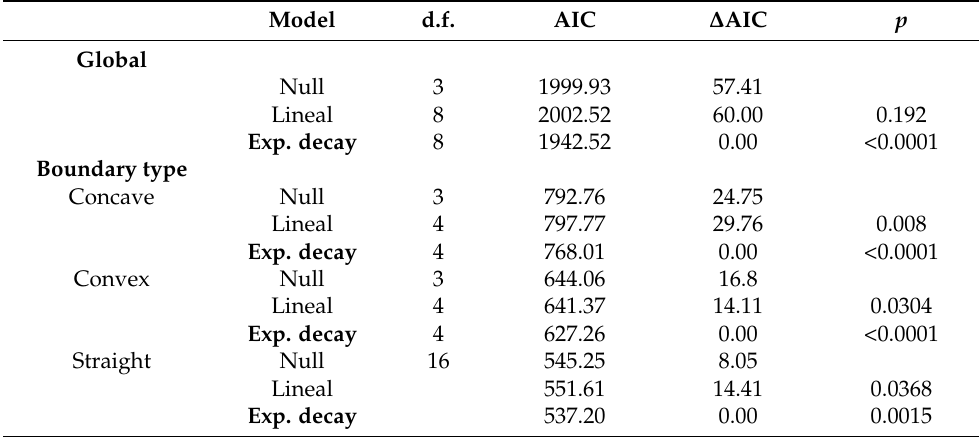
Table A3. Results of Linear Mixed Models (LMM) describing how browsing intensity in mines varied with increasing distance to the forest edge. The best models (lowest AICs) are highlighted in bold. p indicates the significant differences between the null and the alternative models after the